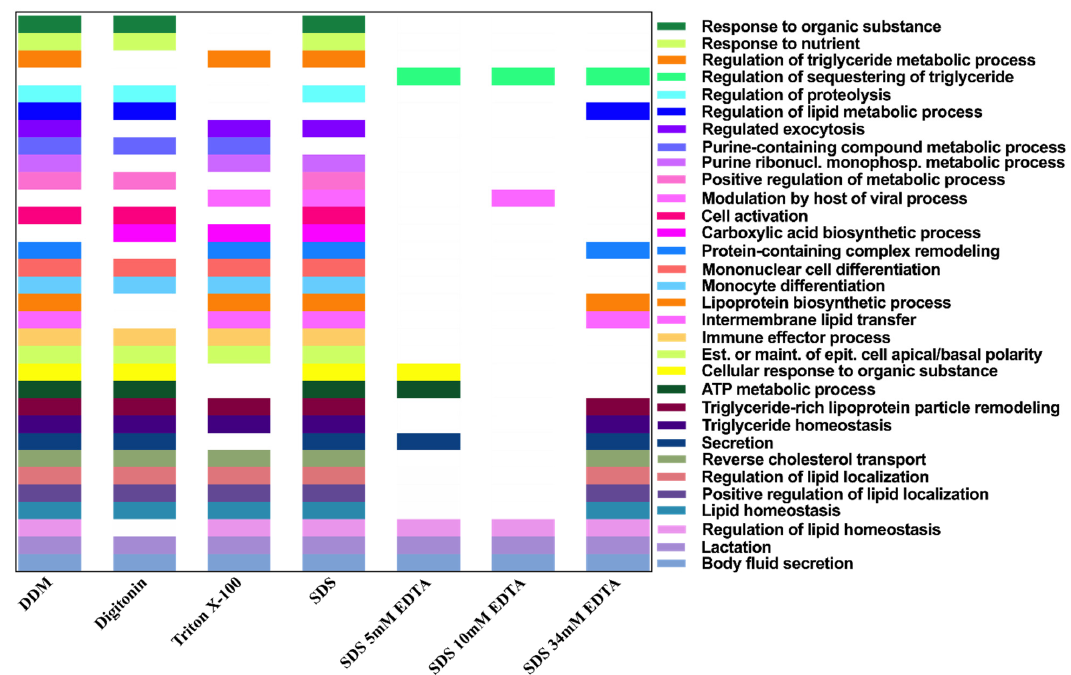
Figure 4. Biological processes corresponding to high confidence proteins detected in human milk extracellular vesicles processed under seven different denaturing conditions. Biological processes that were common to three or more conditions are shown. Highest number of biological processes were identified from human milk extracellular vesicle samples processed with SDS and DDM. Lactation and body fluid secretion were identified across samples under different denaturing conditions. REVIGO analysis of significant GO terms identified by GOrilla analysis, following removal of redundant terms.